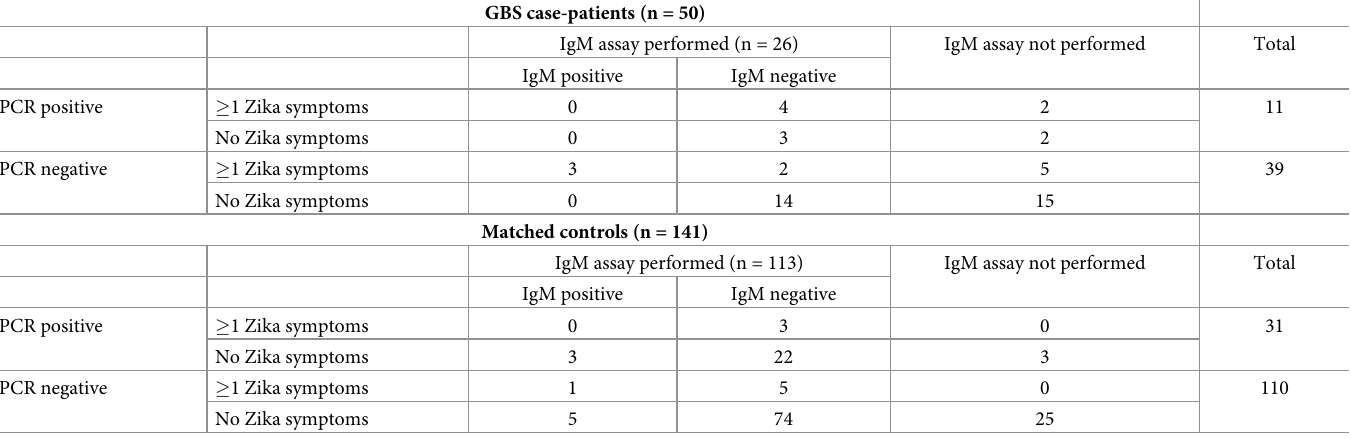
Table 2. Number of GBS case-patients and matched controls by results of Zika PCR test, Zika IgM test, and presence of Zika